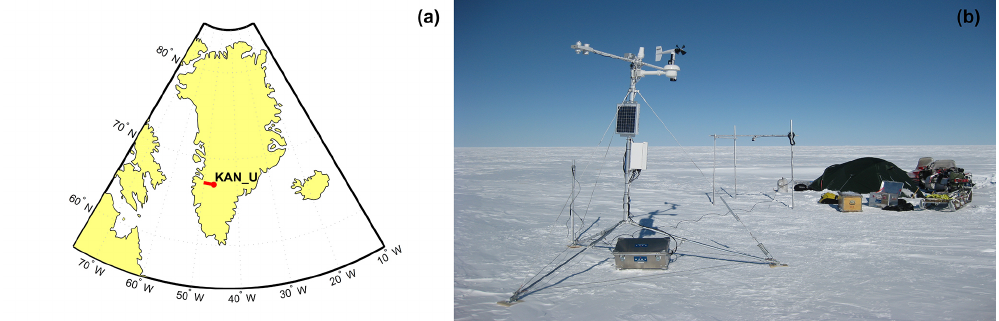
Figure 1. (a) Map of Greenland with the location of KAN_U. (b) Picture taken after the installation of KAN_U (April